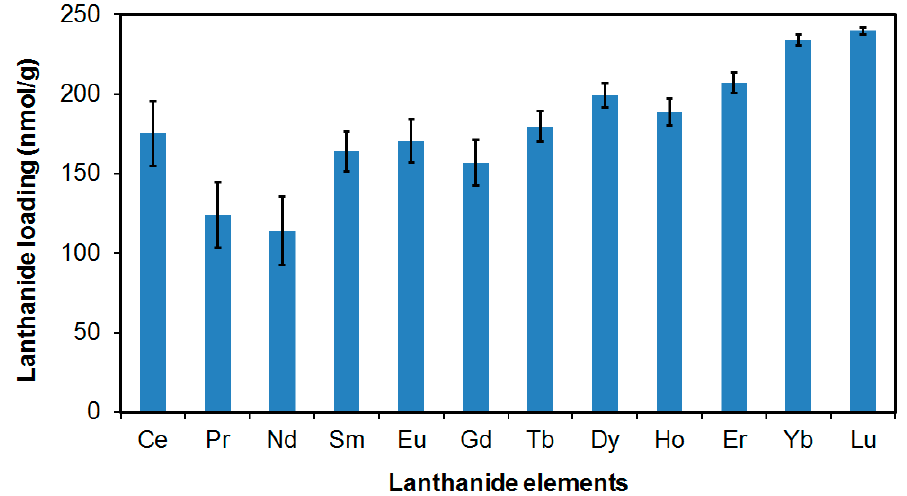
Figure 2. Loading of lanthanide elements on phosphonated MSNPs. A cocktail of lanthanides at 10 µg/L each was in contact with 0.2 mg MSNPs for 2 h.